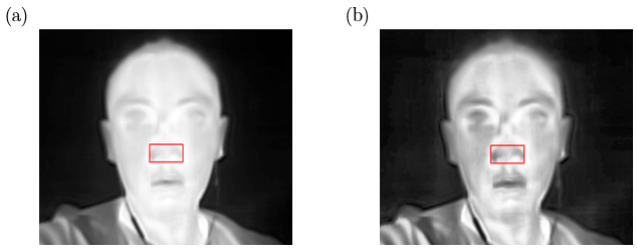
Figure 11. ( a ) Original thermal image with ROI RR detected (red bounding box), ( b ) the contrast of the thermal image enhanced by